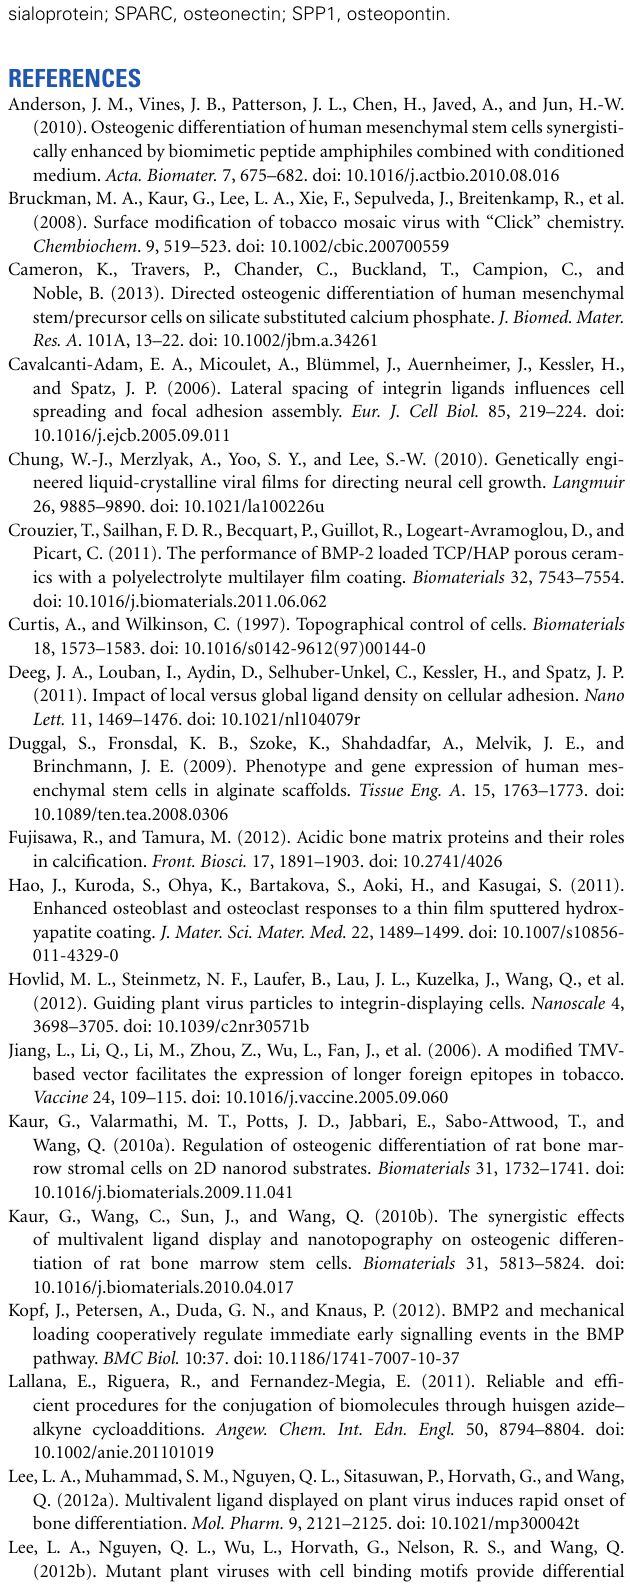
Figure S1 | Primers used for RT-qPCR to measure gene expression levels. ALPL, alkaline phosphatase; BGLAP, osteocalcin; IBSP, integrin-binding sialoprotein; SPARC, osteonectin; SPP1,